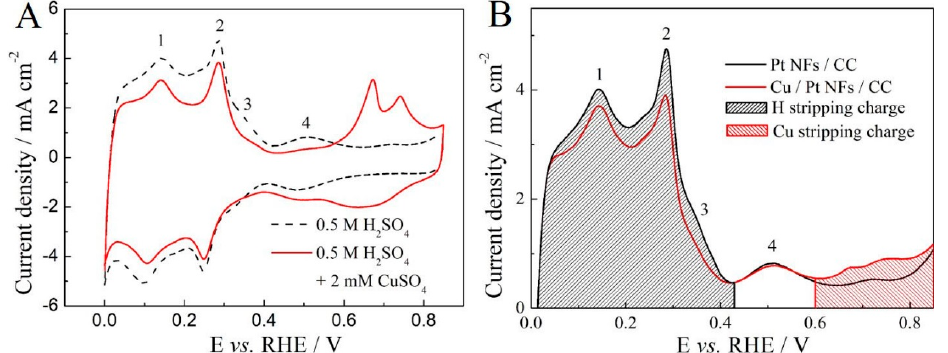
Figure 3. Cyclic Voltammetry of Pt NFs / CC ( A ) in a solution of absence (dash line) and presence of 2 mM Cu 2+ (solid line); ( B ) H stripping curve of Pt NFs / CC (blank curve) and Cu stripping curve of Cu / Pt NFs / CC (red curve) in 0.5 M H 2 SO 4 , scan rate is 20 mV s − 1 .